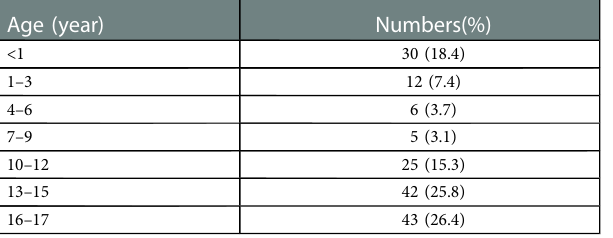
TABLE 1 Age distribution of the patients.